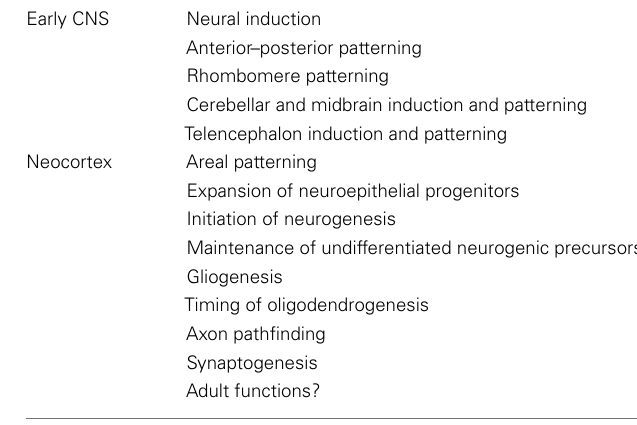
Table 1 | Examples of functions for FGF signaling in the nascent central nervous system and developing